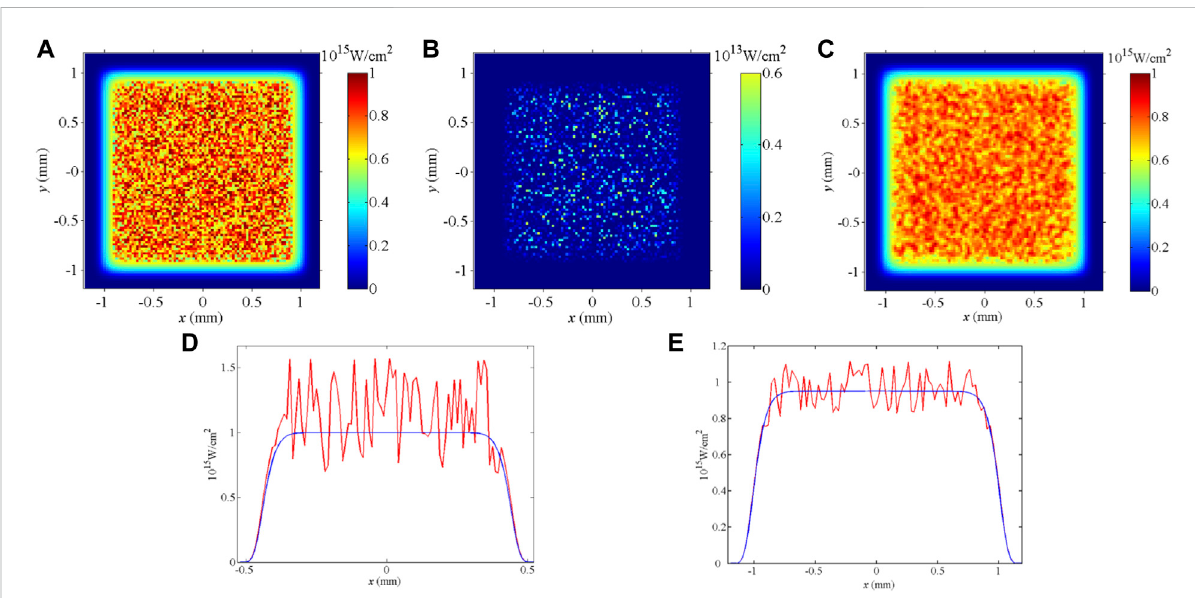
FIGURE 3 Intensitydistributionsoflaserbeam: (A) injectedlaserbeam; (B) scatteredlaserbeam; (C) outputsmoothedlaserbeam; (D) 1Dcurveofinjected light; (E) 1D curve of output light. To quantitatively analyze the beam smoothing effect, the fractional power above intensity (FOPAI) was evaluated using Eq. 11.